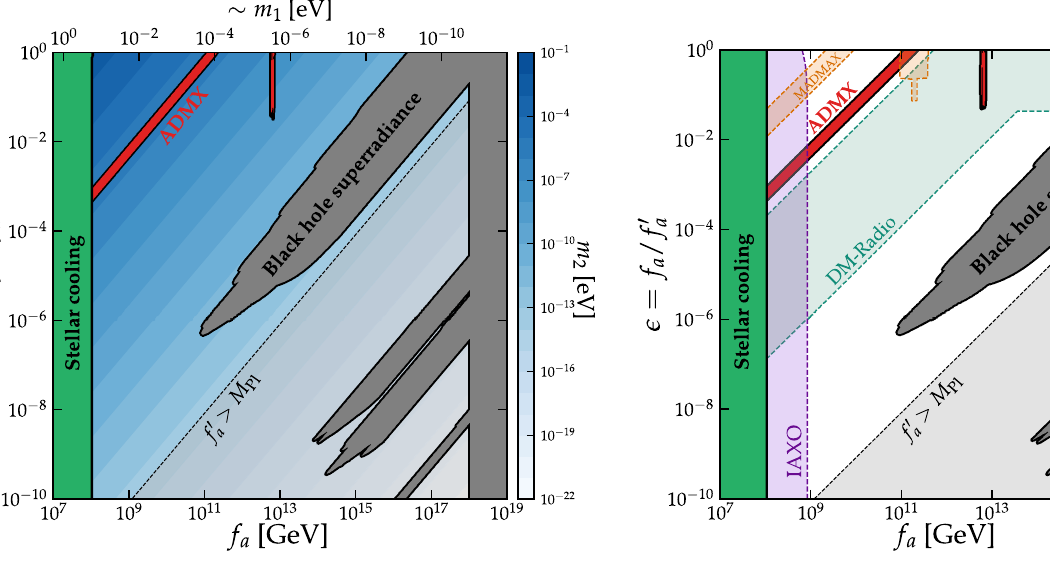
Fig. 2 Left: current bounds on the companion-axion model. The col- orscale corresponds to the value of the lighter axion’s mass, whereas the heavier axion’s mass is shown (roughly) by the upper horizontal axis. We can rule out parts of this parameter space using stellar cooling argu-